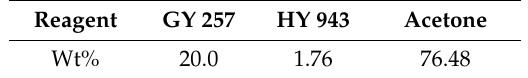
Table 1. Concentration details for the preparation of the epoxy